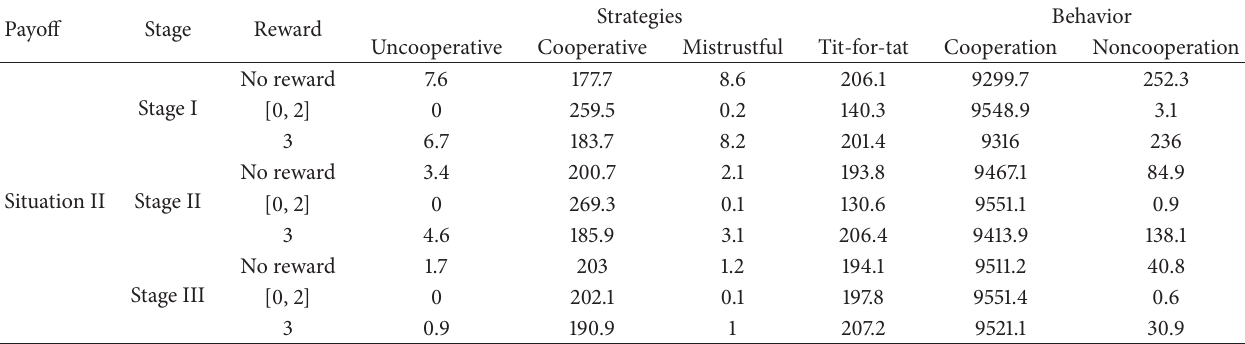
Table 5: Average frequencies of different strategy in Situation II of innovation with each incentive.